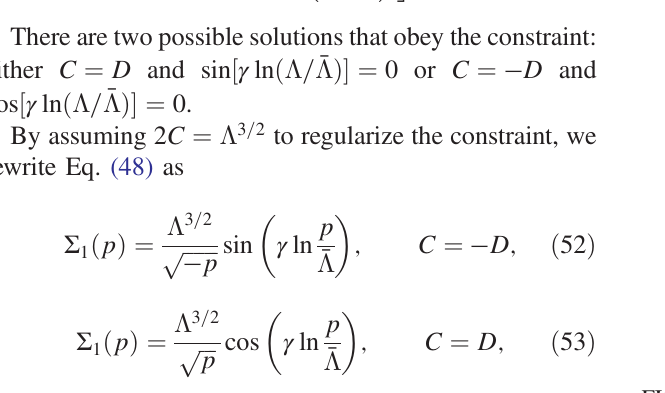
FIG. 1. Graphical representation for solutions of the transcen- dental equation. The value of γ is artificial, to facilitate the